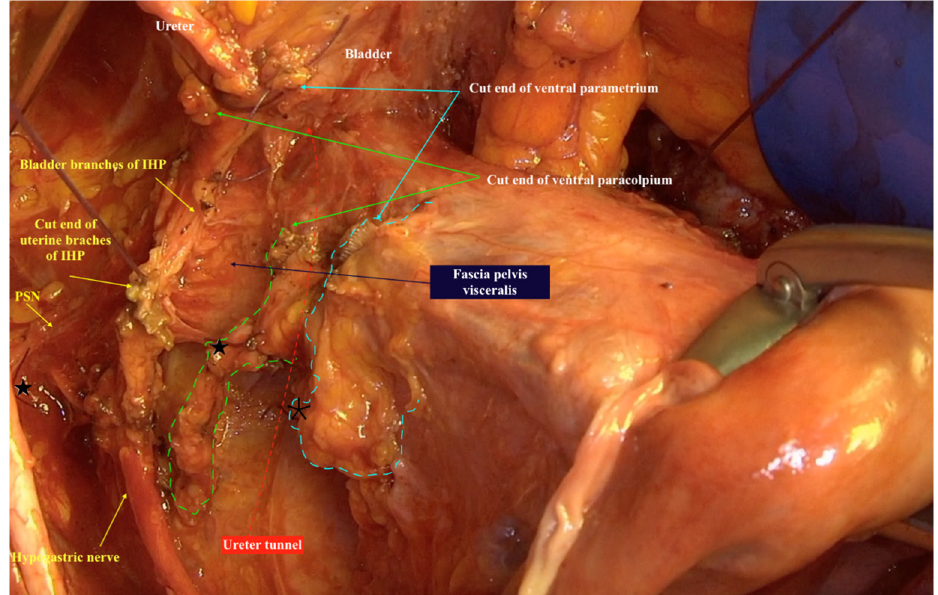
Figure 2. The resected three-dimensional parametrium above the ureter/ureter tunnel and the re- sected three-dimensional paracolpium beneath the ureter/ureter tunnel in type IV Muallem classi- fication of radical hysterectomy. The spared left hypogastric nerve, left inferior hypogastric plexus and their branches to the bladder are even good to be seen lateral from the specimen. Parametrium marked with a dotted blue line, paracolpium marked with a dotted green line, ureter tunnel marked with a dotted red line. ★ cut end of vaginal vessels (wrongly known as deep uterine vein), * cut end of uterine vessels, IHP: inferior hypogastric plexus, PSN: pelvic splanchnic nerves.